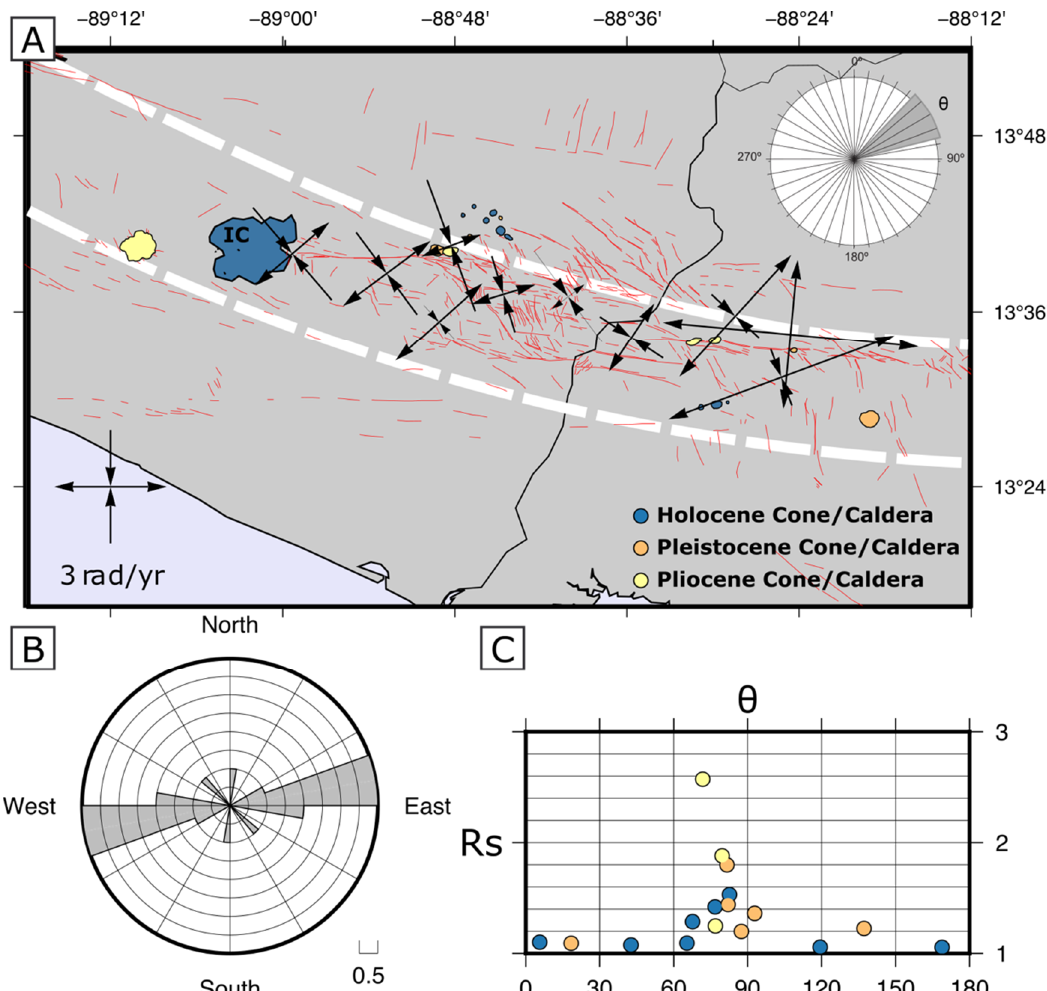
Figure 5. ( A ) Black arrows show the orientation of the principal axes of the horizontal strain rate tensors (according to GPS data). White dashed lines are the boundaries of the ESFZ. Colored polygons are the caldera and edifice borders used to constrain the 2D horizontal finite strain ellipsoid IC: Ilopango Caldera. ( B ) Rose diagram of the orientation of the long axes of the best fit ellipse for each caldera. ( C ) Rs/ θ diagram of the best fit ellipse of each caldera. Rs is the ellipticity (length ratio of long to short axes of each caldera), while θ is the angle that the long axis forms with the azimuth of the ESFZ borders. Colors are the ages of each caldera based on [68,69]: Blue for Holocene, orange for Pleistocene and yellow for